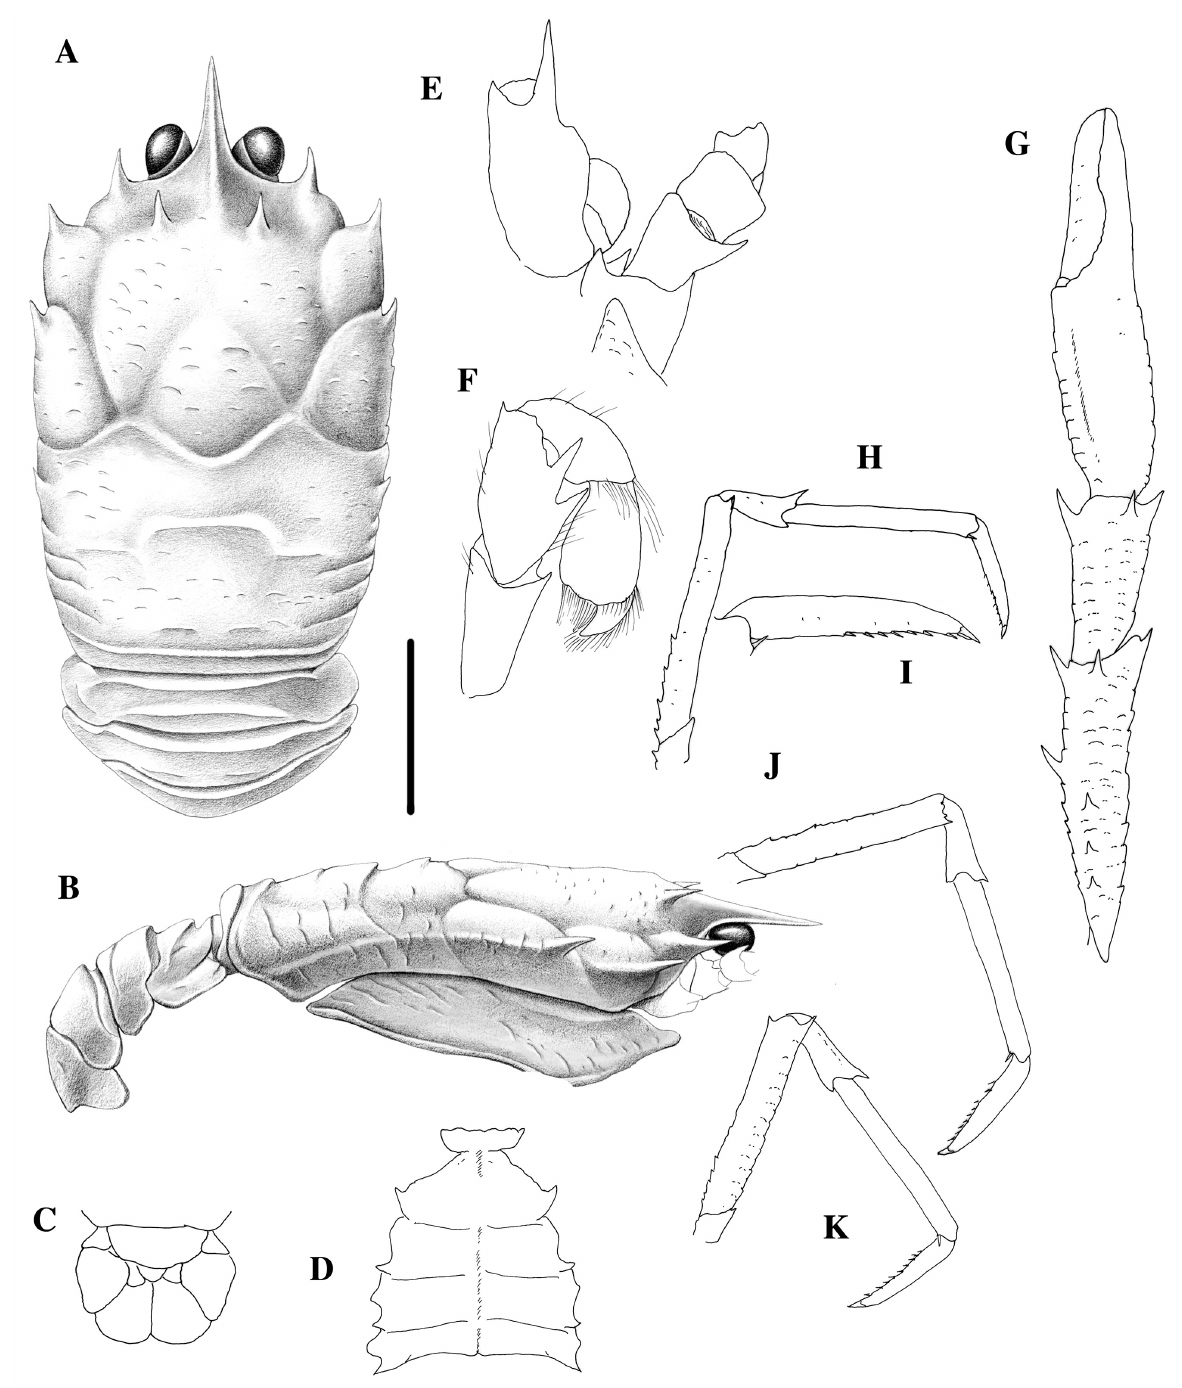
Fig . 1. – Munidopsis ariadne n. sp. Holotype, male 6.0 mm (ICMD-20110120_01). A, carapace and abdomen, dorsal view. B, carapace and abdomen, right lateral view. C, telson. D, sternal plastron. E, left antenna and antennula, ventral view. F, right maxilliped 3. G, right P1. H, Right P2. I, Right P2 dactylus. J, Right P3. K, Right P4. Scale: A-D, 2.0 mm; G, H, J, K, 1 m; E-F, I, 0.5 Eye : Ocular peduncle immobile. Cornea subglobu- lar, non-pigmented, unarmed, as wide as eyestalk. Antennule : Basal article of antennular peduncle with strong distolateral spine, distomesial spine small; lateral margin swollen, with minute tubercle. SCI. MAR., 75(3), September 2011, 525-532. ISSN 0214-8358 doi: 10.3989/scimar.2011.75n3525